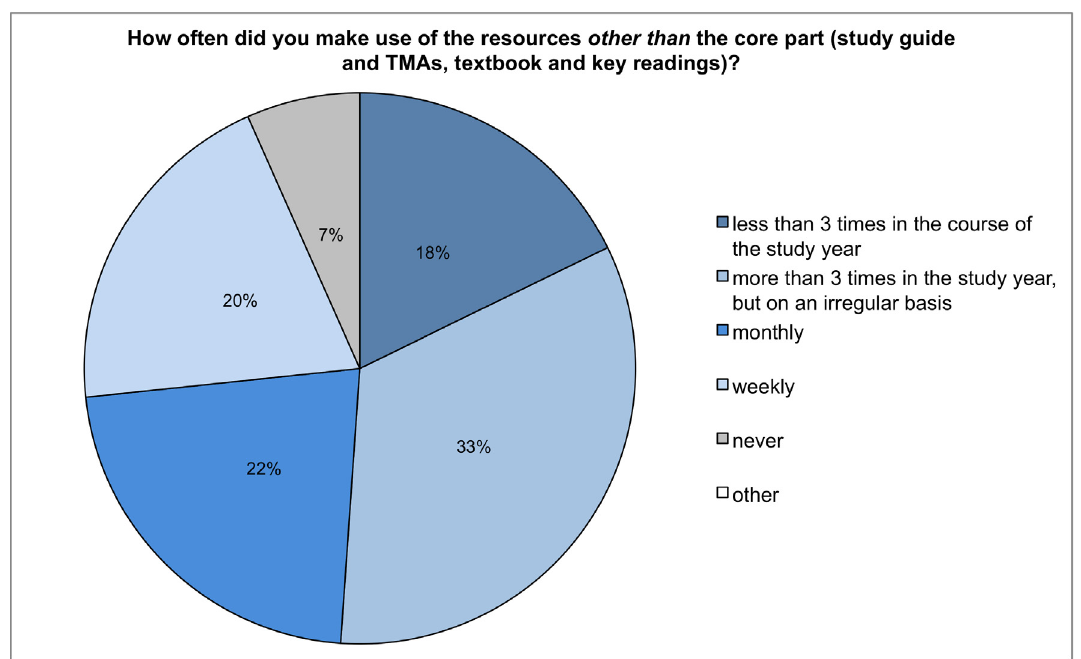
Figure 5 . Frequency of student use of extra, non-examinable resources